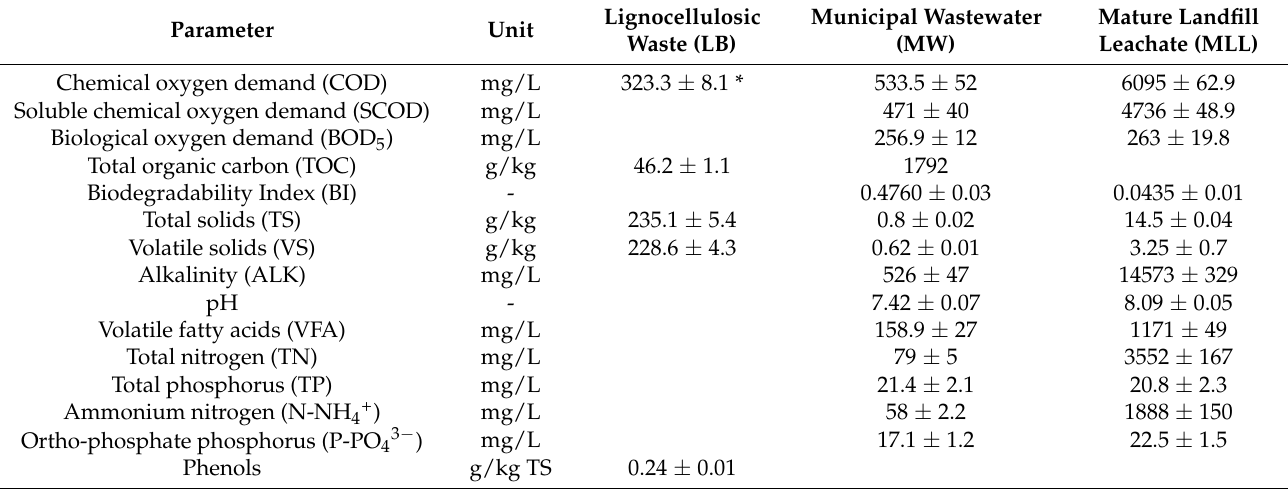
Table 1. Characteristics of substrates (average values and standard